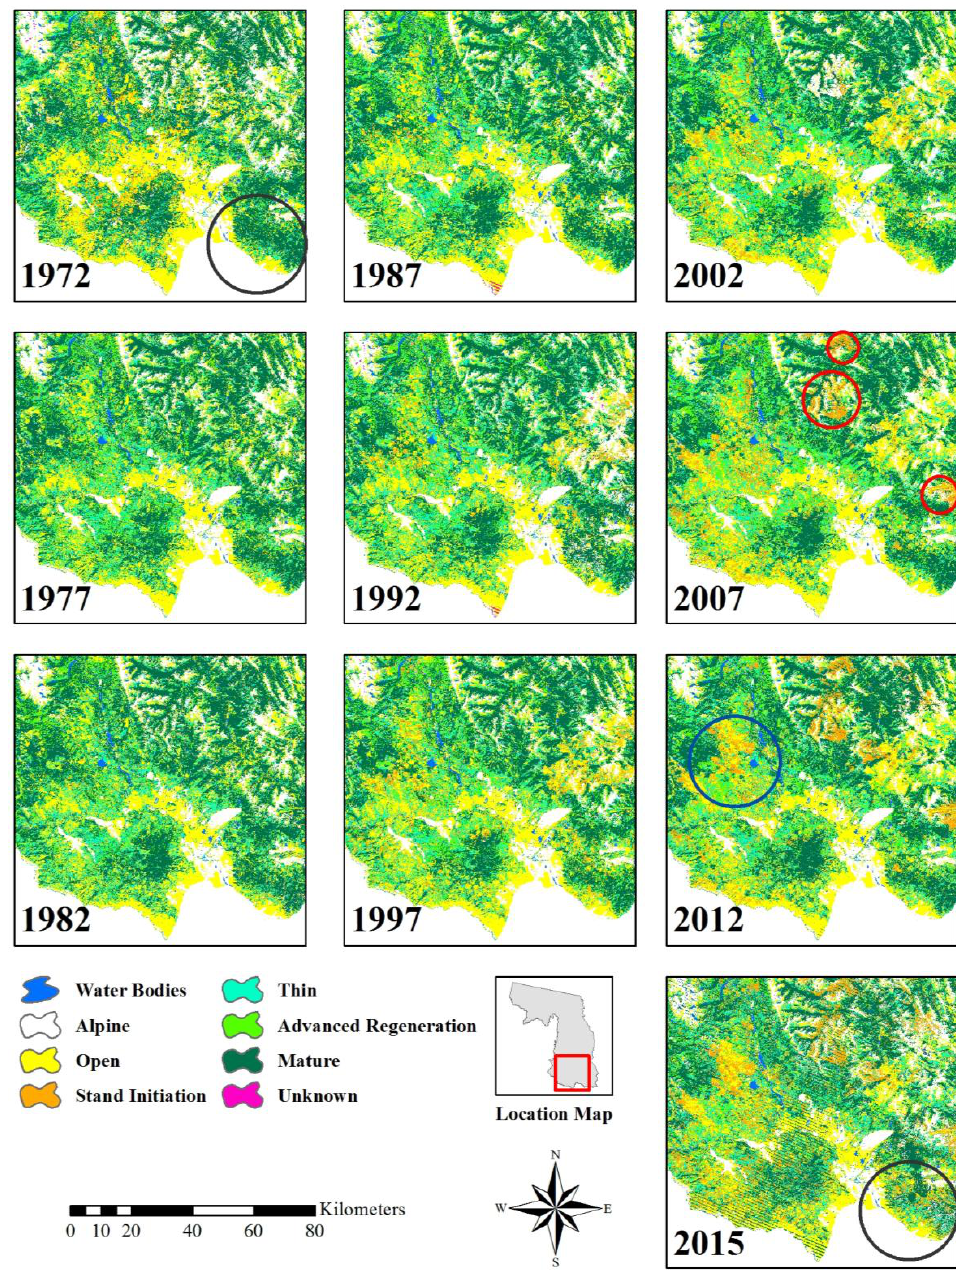
Figure 8. Changes in forest structure classification from 1972 to 2015 within the southern portion of our study area. Fire scars (red circles in 2007) and clear cuts (blue circle around checkerboard pattern in 2012) are the most obvious visual changes. Insect damage is observed as a gradual decrease of the Mature class over the course of the time series (as seen from 1972 to 2015 in black circles).